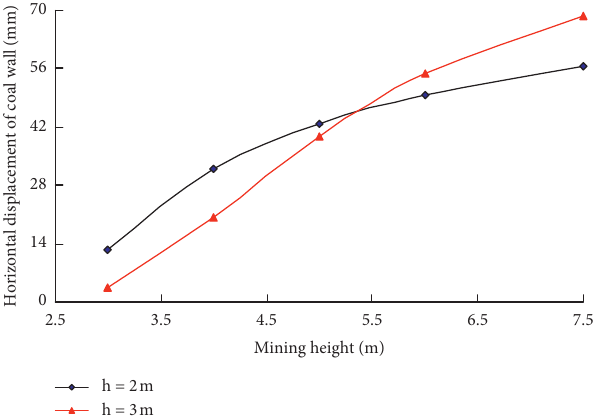
Figure 9: Variation curves of subsidence quantity with initial supporting force.